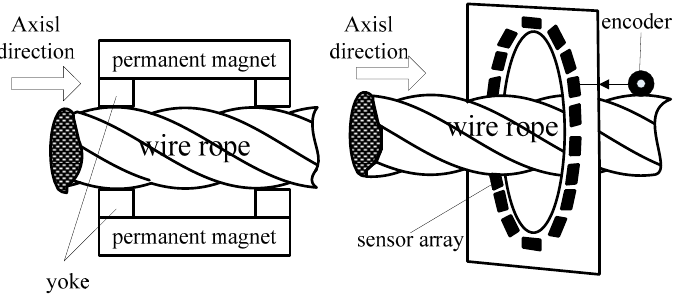
Figure 2. Schematic diagram of the RMF detection process.